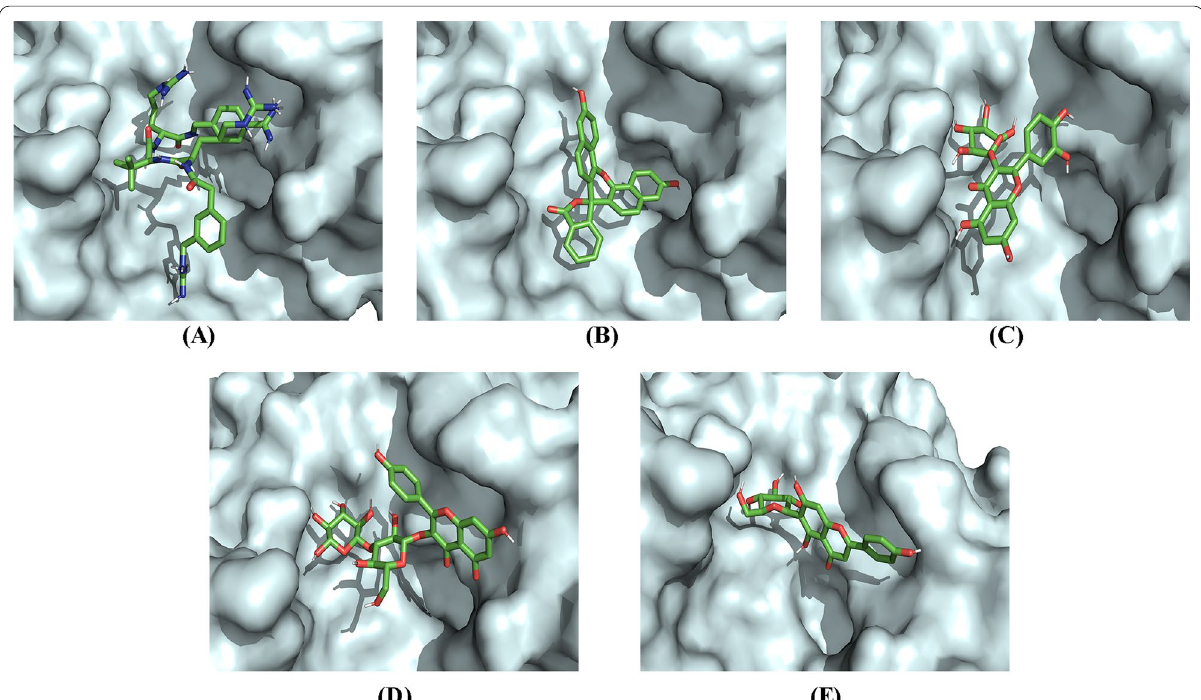
Fig. 7 3-dimensional view at the biding pose of ( a ) PGPRTRA, ( b ) Naphthofluorescein, ( c ) C_18, ( d ) C_4 and ( e ) C_5 at the active binding pockets of furin